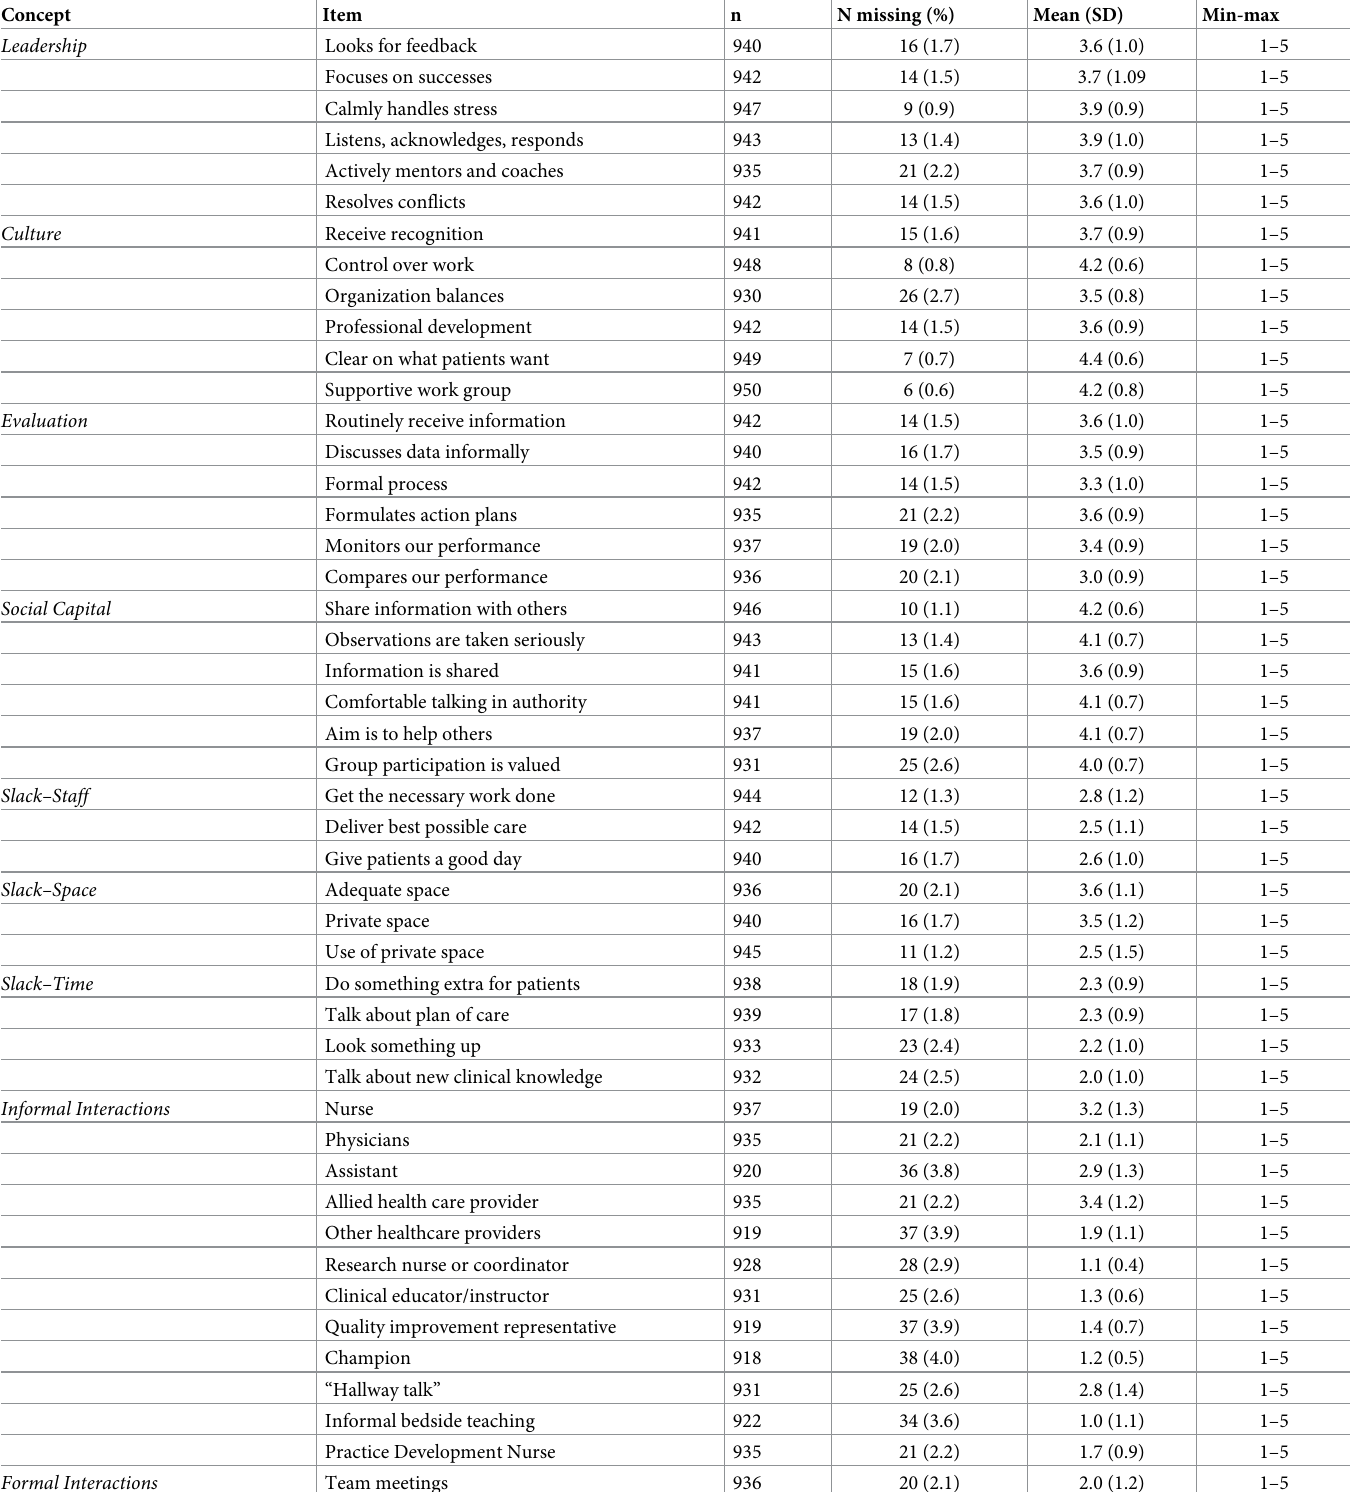
Table 2. ACT item